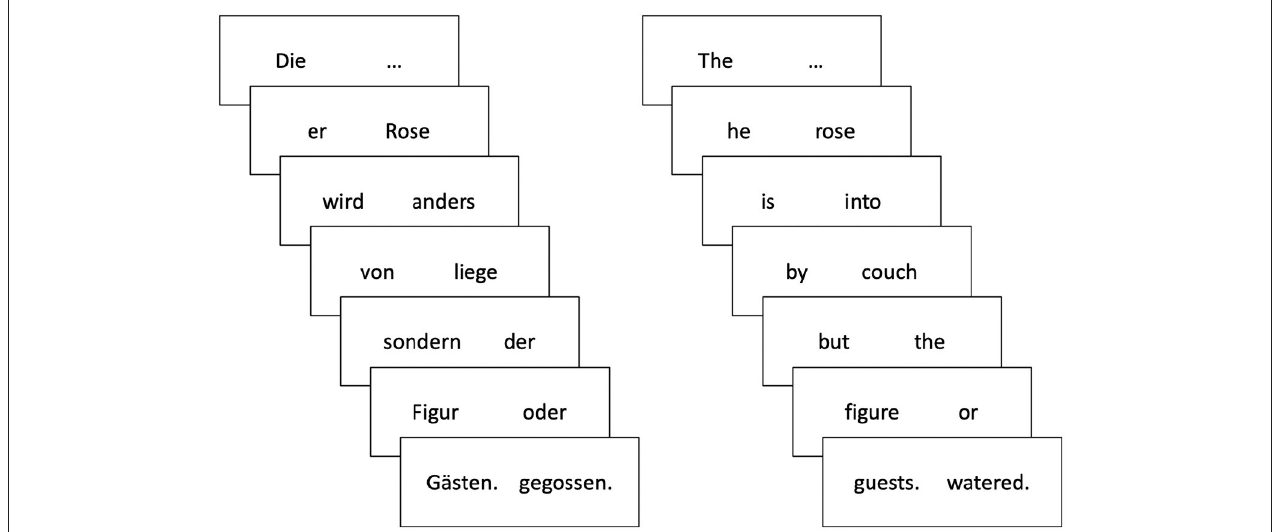
FIGURE 3 | Experiment 2: Structure of the G-Maze task for the example sentence, Die Rose wird von der Figur gegossen (left) , and its rough English translation “The rose is by the figure watered” (right) . Sentences were presented word by word as a sequence of forced choices between two alternatives, only one of which continued the sentence